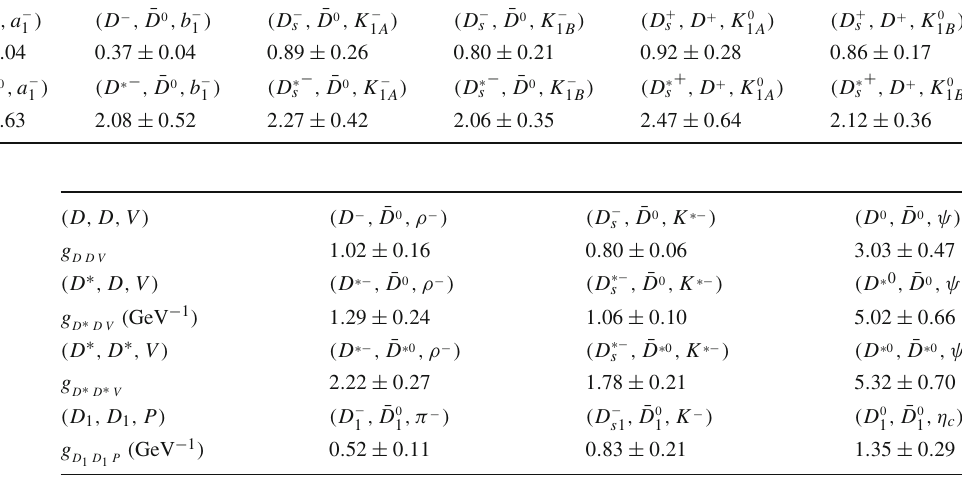
Fig. 3 Plots of the wave functions ψ 1 P = (π − , K − , D − , D − s ,η c ) as functions of the radial coordinate z in the interval (ε, z 0 ) Table 5 Our predictions for the strong couplings of ( D , D , A ) and ( D ∗ , D , A ) vertices